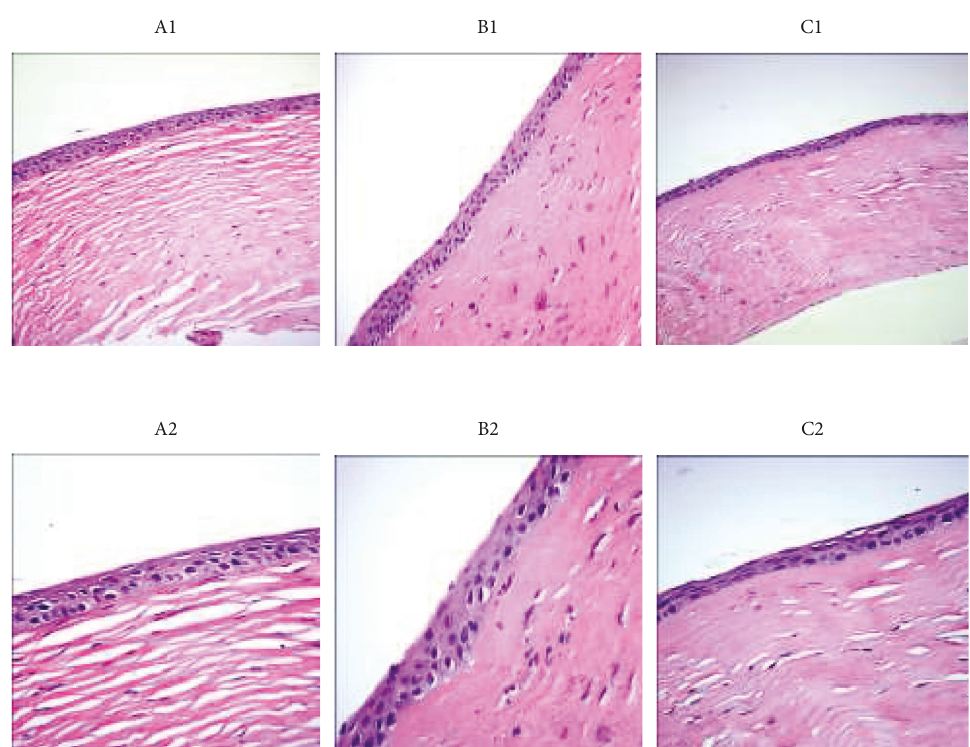
Figure 2: Electron microscope images in each group at 72h after operation. Electron microscopic images of group A (A1), B (B1), and C (C1) under 200x magnification; electron microscopic images of group A (A2), B (B2), and C (C2) under 400x magnification. Group A: there are 5–6 layers of corneal epithelium; no obvious neovascularization is seen at corneal limbus; the matrix collagen structure is densely and regularly arranged. Group B: there are 4–5 layers of corneal epithelium; new blood vessels can be seen at the corneal limbus; the matrix collagen structure is densely and regularly arranged. Group C: there are 2–3 layers of corneal epithelium; a large number of new blood vessels can be seen at the corneal limbus; the number of fibroblasts in the stromal layer is reduced, and a large number of inflammatory cells are observed; matrix collagen structure is slightly loose but relatively